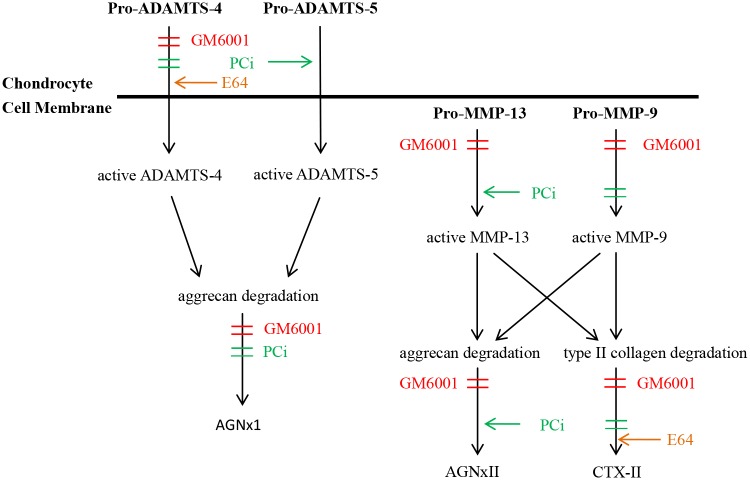
The schematic diagram of the effects of inhibitors on protease activation and cartilage degradation.The broad MMP inhibitor, GM6001 (red color), almost completely inhibited the activation of Pro-ADAMTS-4, Pro-MMPs and cartilage breakdown, since the efficient gaining of activities of both pro-enzymes is MMP-dependent process. Addition with Furin-like convertase inhibitor, PCi (green color), decreased the release of active ADAMTS-4 and AGNxI induced by T+O, but induced huge release of active ADAMTS-5, suggesting active ADAMTS-4 is the predominant aggrecanase for the generation of AGNxI in T+O treated-bovine cartilage explants. PCi promoted the activation of MMP-13 and AGNxII, but not MMP-9. Blockade of cysteine proteases by E64 increased the levels of active ADAMTS-4 and the release of CTX-II, whereas had little effect on the activation of MMP-13 and MMP-9, demonstrating that other compensatory collagenases possibly were triggered following by the inhibition of cysteine protease activity. In summary, the activation of pro-enzyme is a key point in cartilage degradation of T+O treated bovine cartilage, which is regulated in an integrated cascade process.